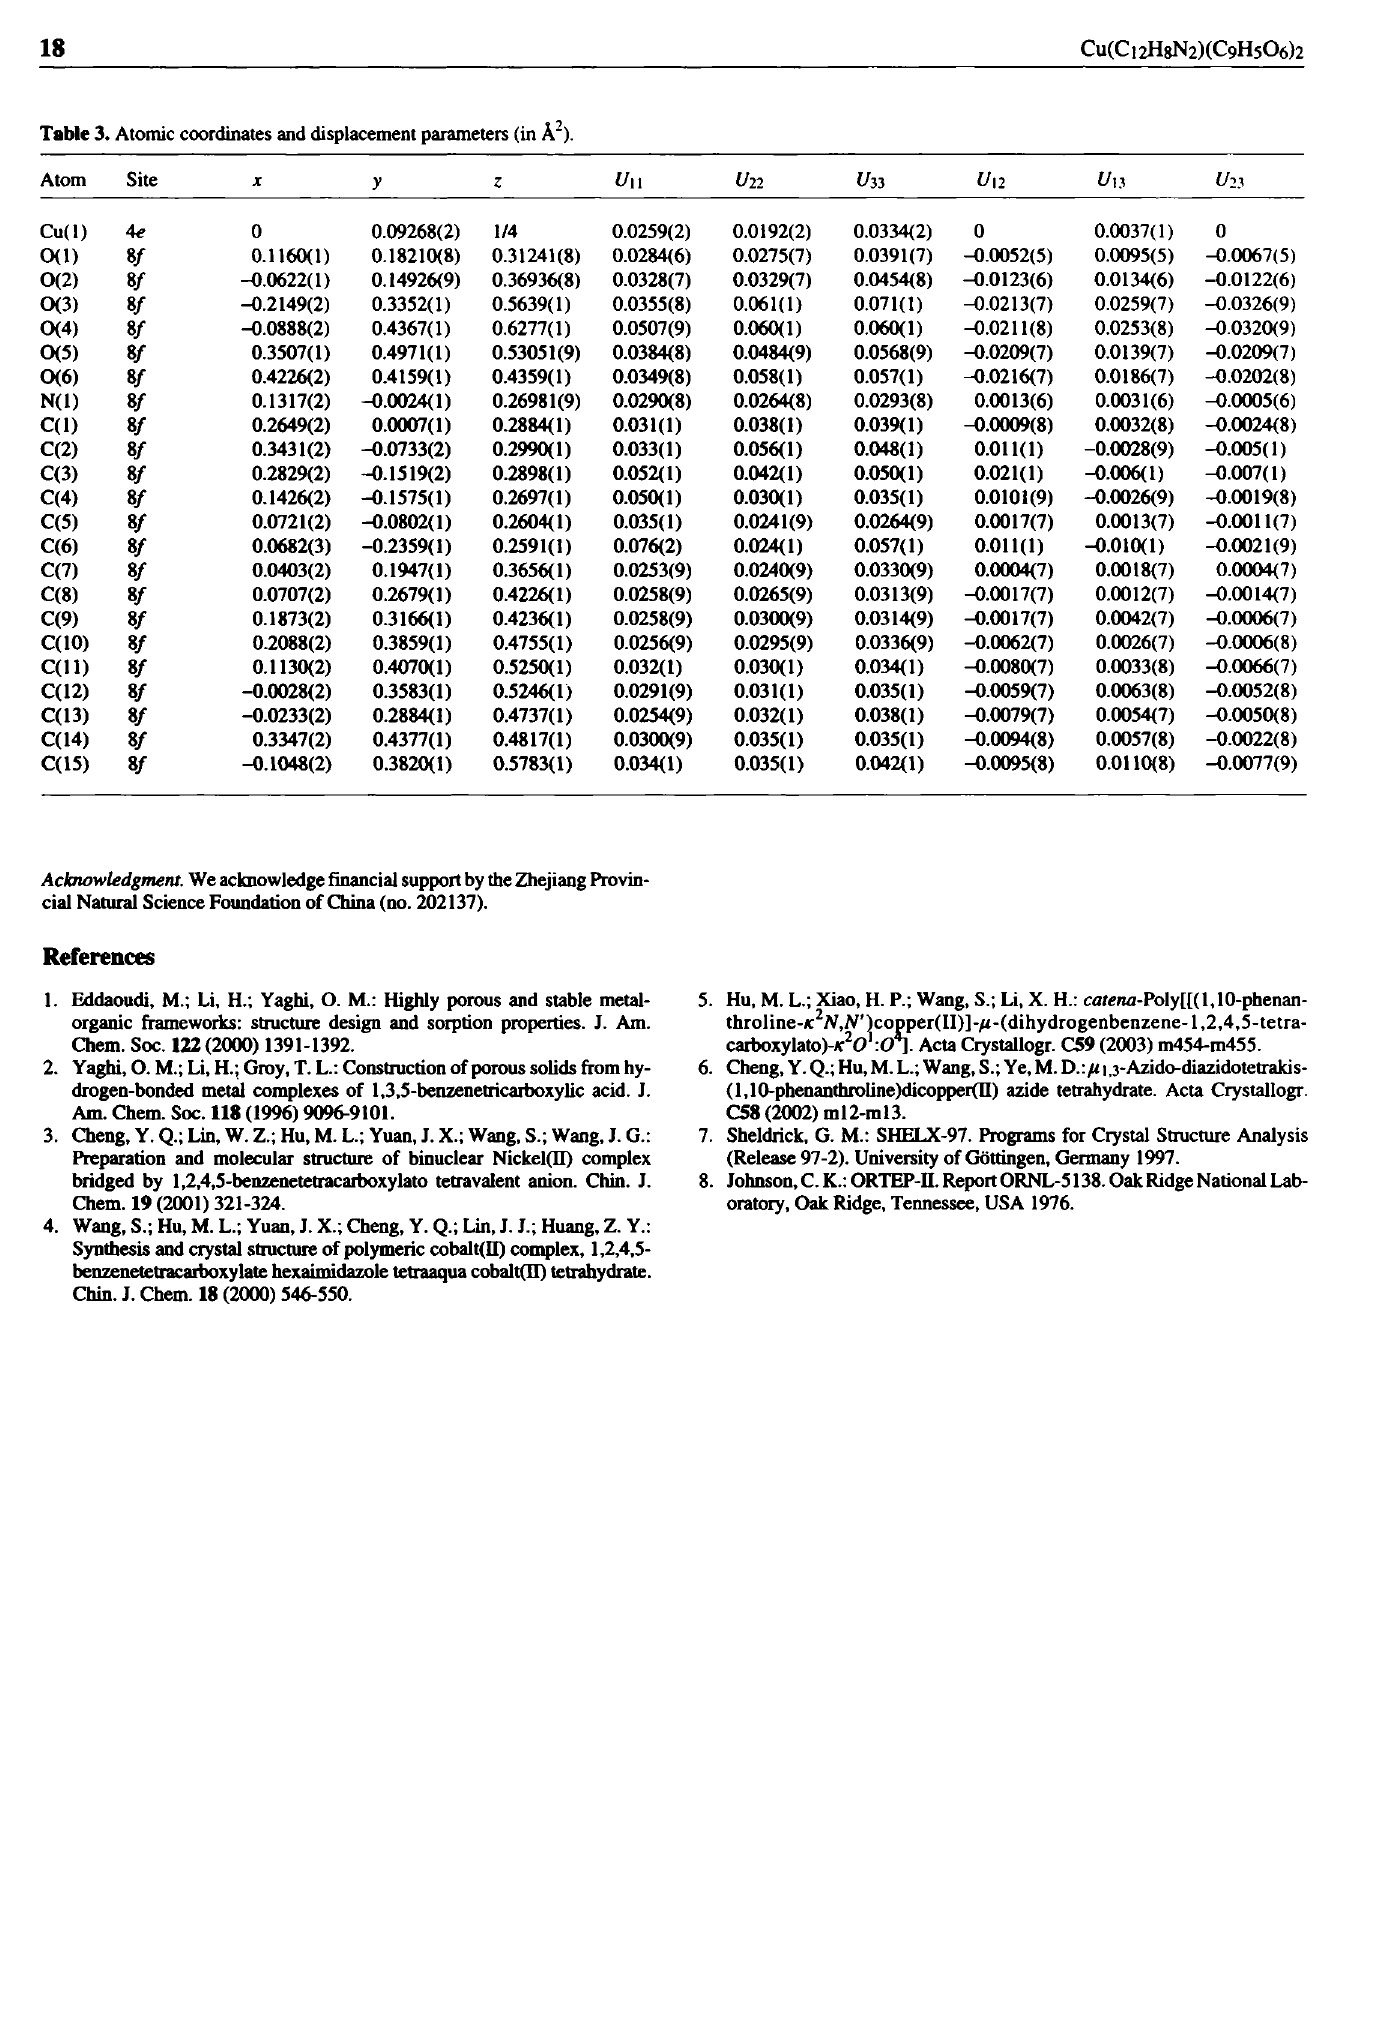
Table 3. Atomic coordinates and displacement parameters (in A 2